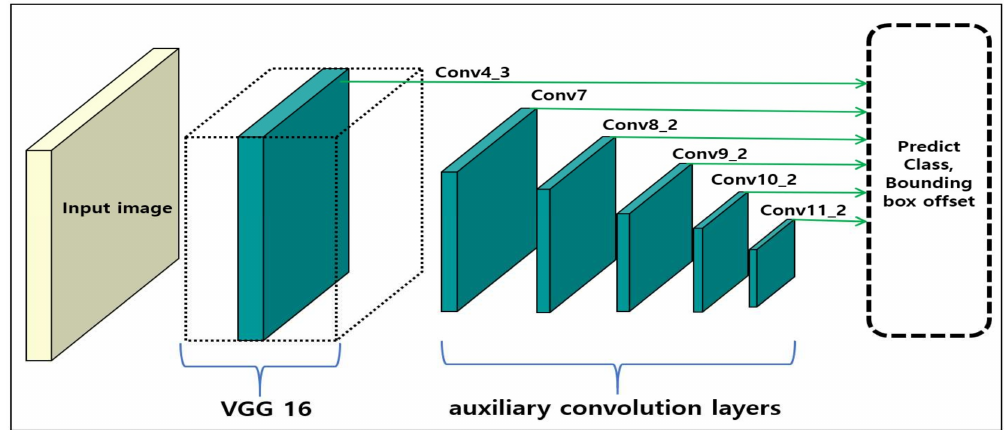
Figure 1. SSD—multiple feature maps (Conv4_3, Conv7, Conv8_2, Conv9_2, Conv10_2, and Conv11_2) are used to independently predict the class and location of the